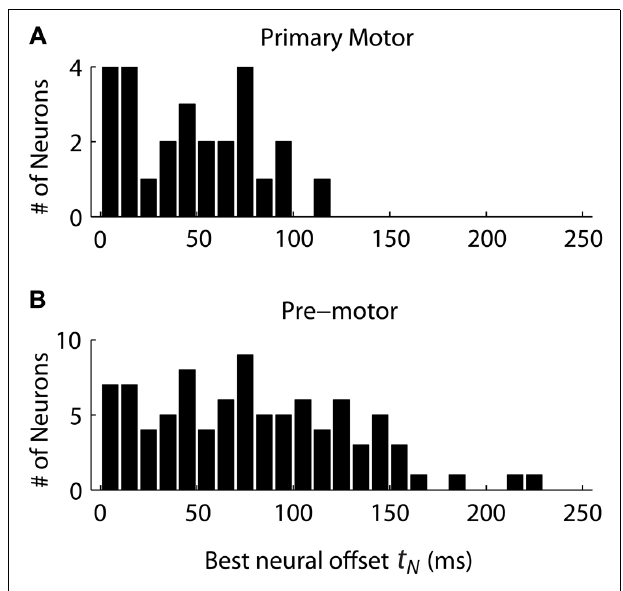
FIGURE 4 |The distribution of neural offsets is compared between neurons from the primary motor cortex (A) and the premotor cortex (B), including both dorsal and ventral premotor cortices. The neural offset describes the time at which the “Replaced” hypothesis predicts a shift from coding the primary movement to coding the secondary movement (see Figure 1